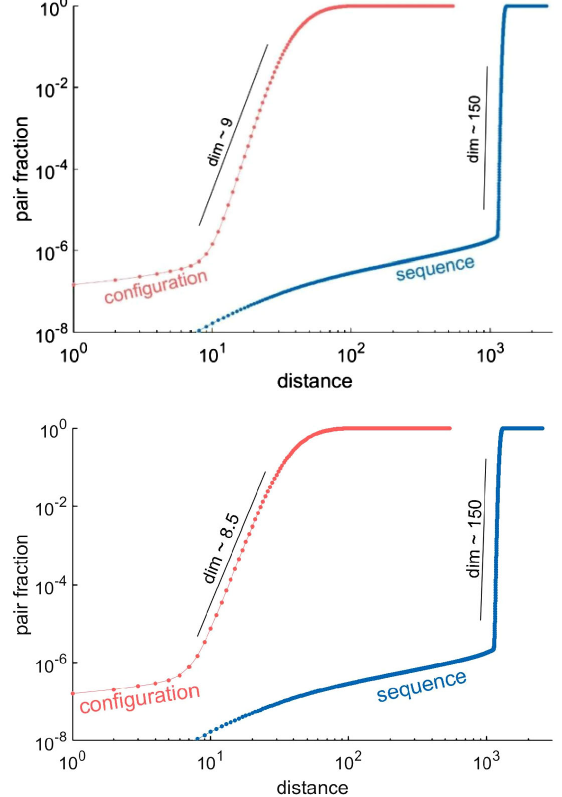
FIG. 2. Evolution of mechanical function. Top: An initial configuration with a given input (black ellipse at bottom) and a random sequence is required to evolve into a straight fluid channel ( S ) or a tilted one ( T ). Bottom: Following the success of evolution. In each generation, a randomly drawn bit (a letter in the five-bit codon) is flipped, and this point mutation is changing one bond (similar to point mutations that change one base in a codon). A typical run is a sequence of mostly neutral steps, a fraction of deleterious ones, and rare beneficial steps. Note that the fitness of the configuration is measured only at the top, not in the interior of the cylinder.